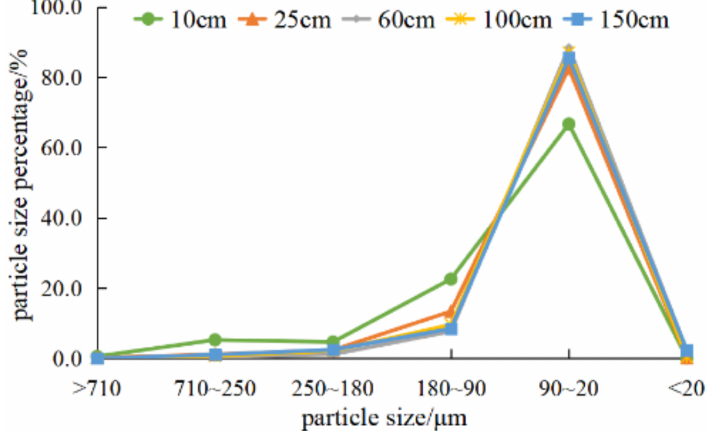
Figure 9. Miyun straw